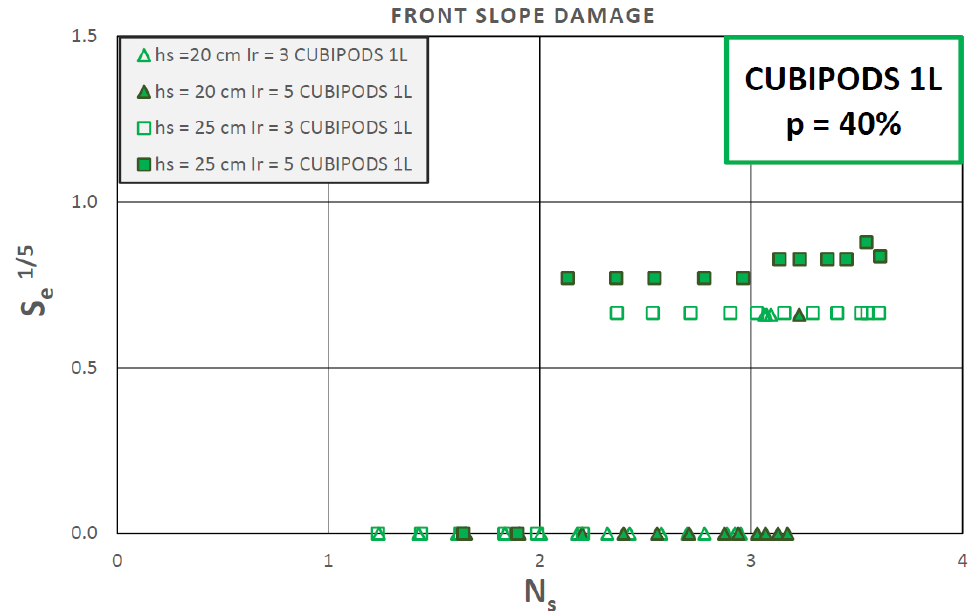
Figure 9. Measured armor damage, S e , to the front slope as a function of the stability number (Cubipod ® armor).